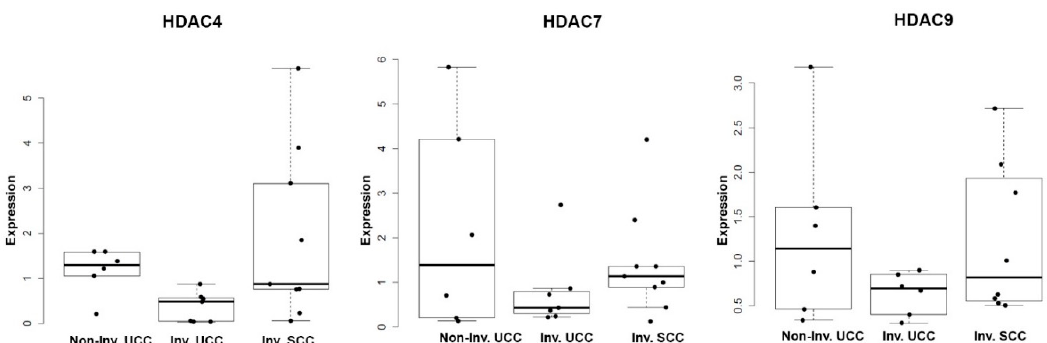
Figure 5. Quantitative real-time polymerase chain reaction (PCR) analysis of Class IIa histone deacetylase (HDAC) expression in bladder cancer (BC) clinical specimens. Boxplot displays of HDAC expression from 24 BC patients. Patients are grouped according to conventional histomorphometric examination (see materials and methods). However, while we note a trend of increased expression of HDAC4 , - 7 , and - 9 in invasive squamous cell carcinoma (SCC) these differences are not statistically significant.